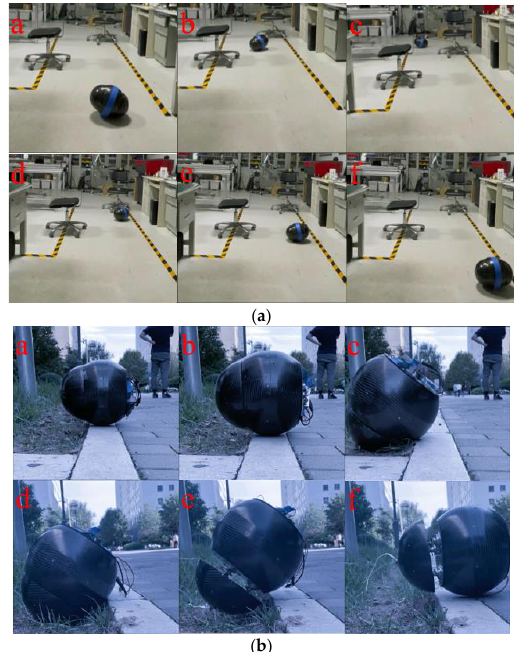
Figure 15. Obstacle avoidance function of the rolling and jumping robot: ( a ) Obstacle avoidance function by rolling motion; ( b ) Obstacle avoidance function by jumping motion.